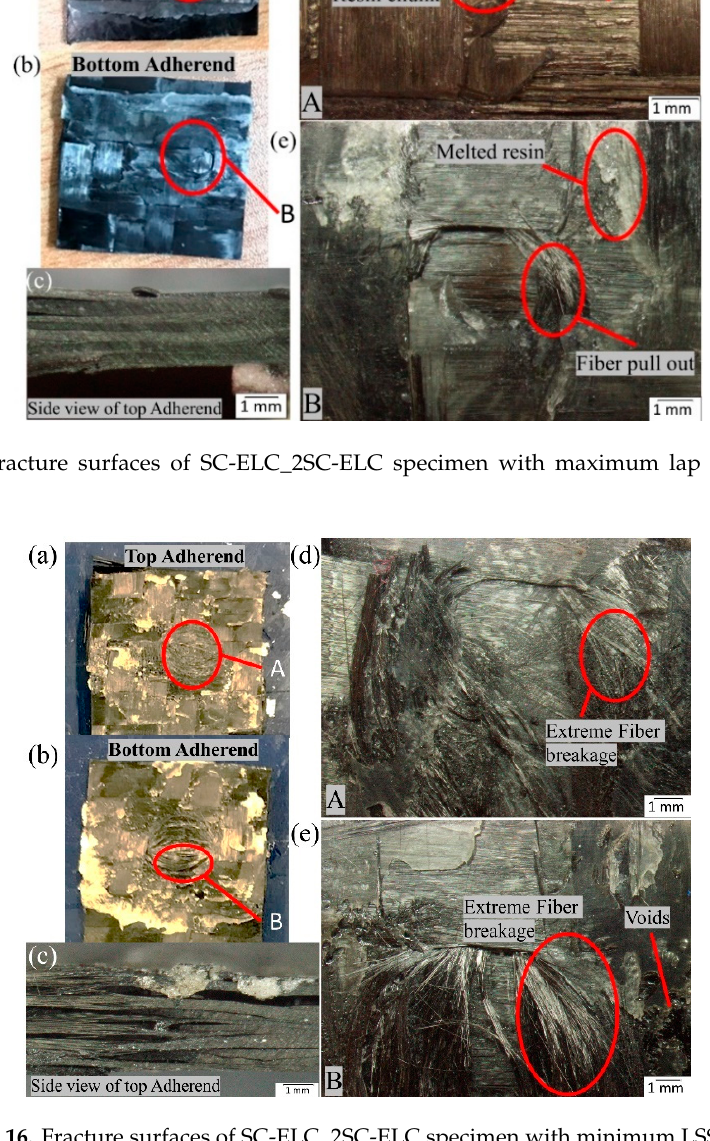
Figure 16. Fracture surfaces of SC-ELC_2SC-ELC specimen with minimum LSS value.